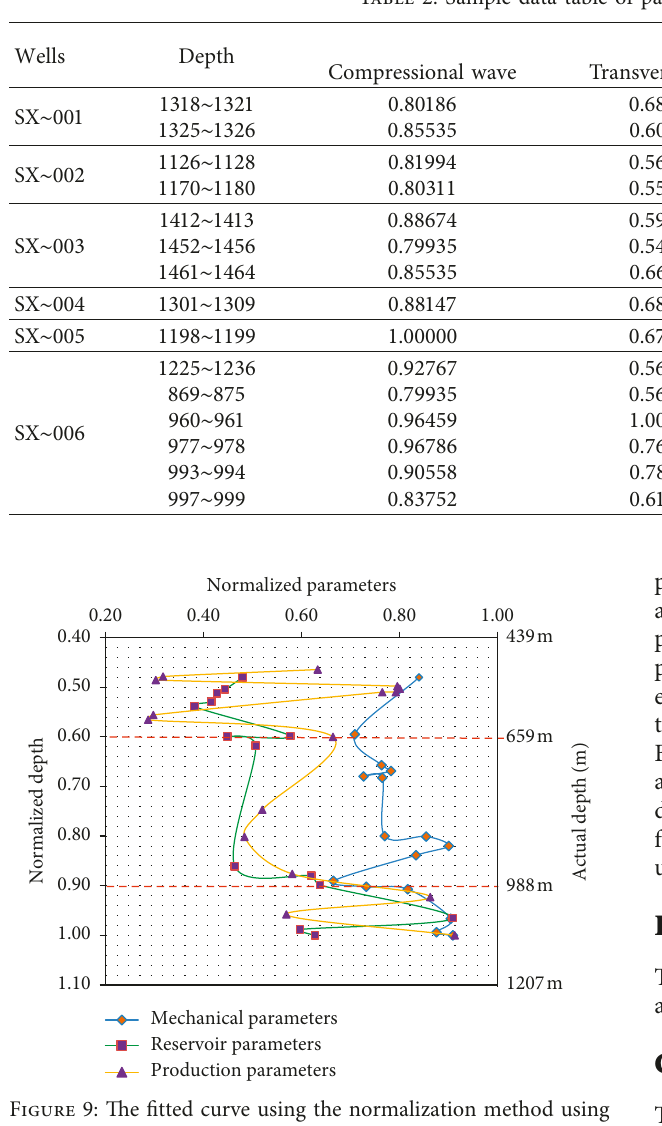
Table 2: Sample data table of parameters after normalized.